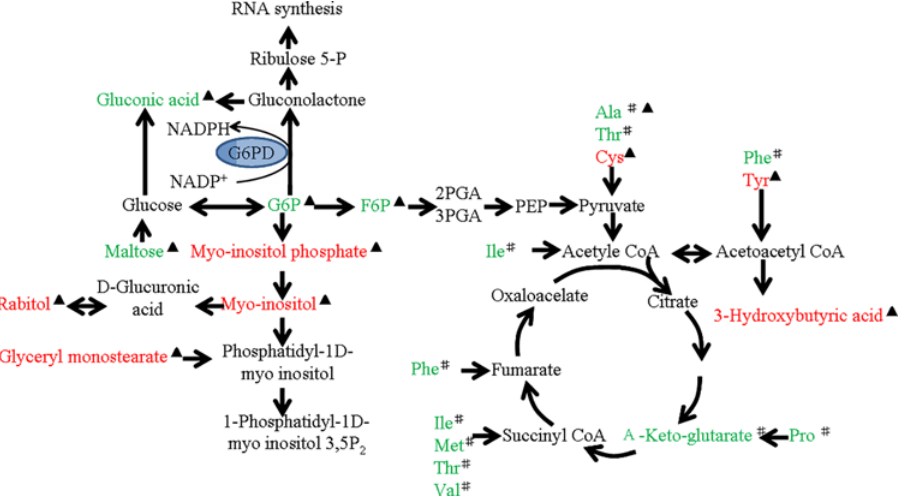
Fig 7. Effects of fava beans on metabolic pathways according to the KEGG PATHWAY database. Putative metabolic pathways were inferred from changes of the intermediates levels in the liver and plasma of the G6PDx-FB mice. Red indicates the significantly elevated metabolites relative to those in the controls. Green shows significantly reduced metabolites relative to those in the controls.